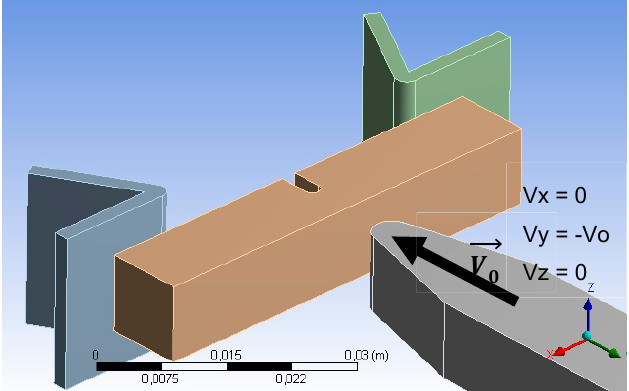
Figure 4. The WPC specimen model and impactor tip used for the Charpy impact test (CIT) test. Initial and boundary conditions on the Charpy V-notch (CVN) specimen.